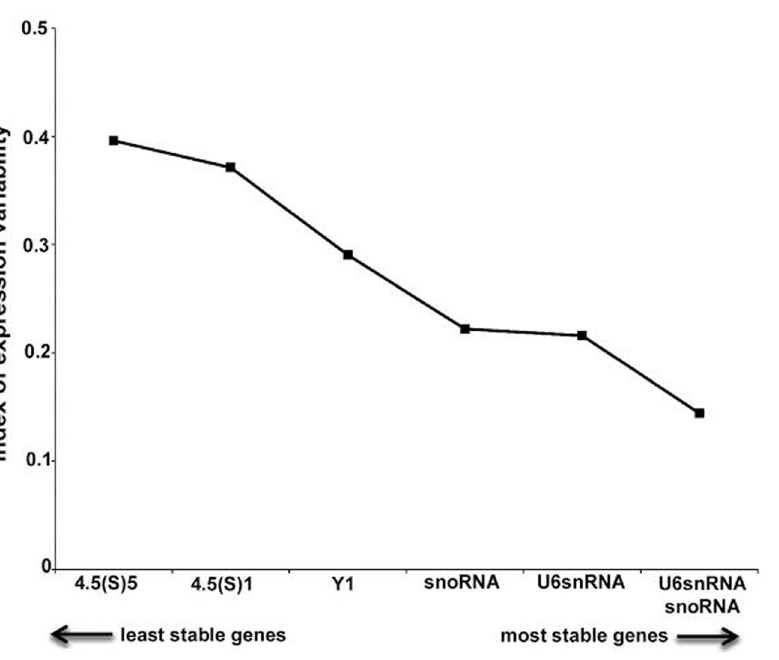
Figure 3. NormFinder analysis of expression stability of candidate reference genes for microRNA qRT-PCR analysis in the systemic PILO-model samples. Ranking of candidate reference genes based on stability values calculated by NormFinder software.